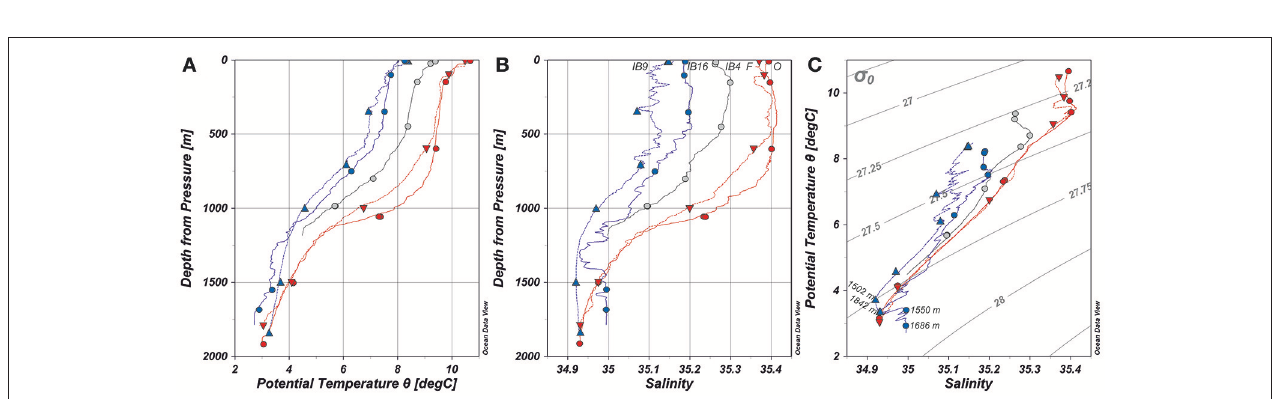
FIGURE 3 | (A) Depth (m) vs. potential temperature ( ◦ C), (B) depth (m) vs. salinity, (C) potential temperature ( ◦ C) vs. salinity with the isopycnals defined by the grey lines, for the open ocean stations in this study during the 2015 EEL. The bottle data are indicated by symbols that correspond to those on the location map